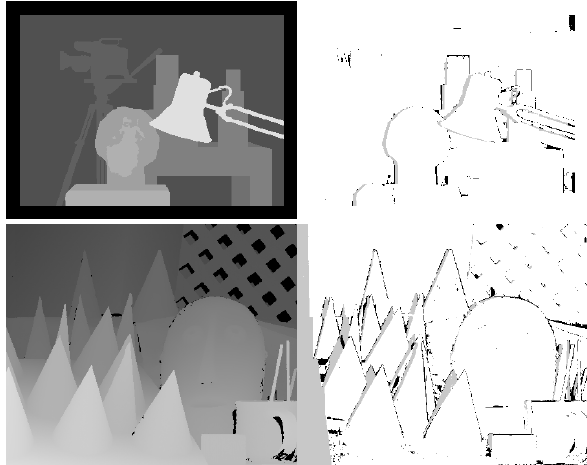
Figure 3. Left: reference disparity maps of the left image of the Tsukuba and Cone stereo-pairs. Right: matching errors due to occlusions (gray) and mismatches